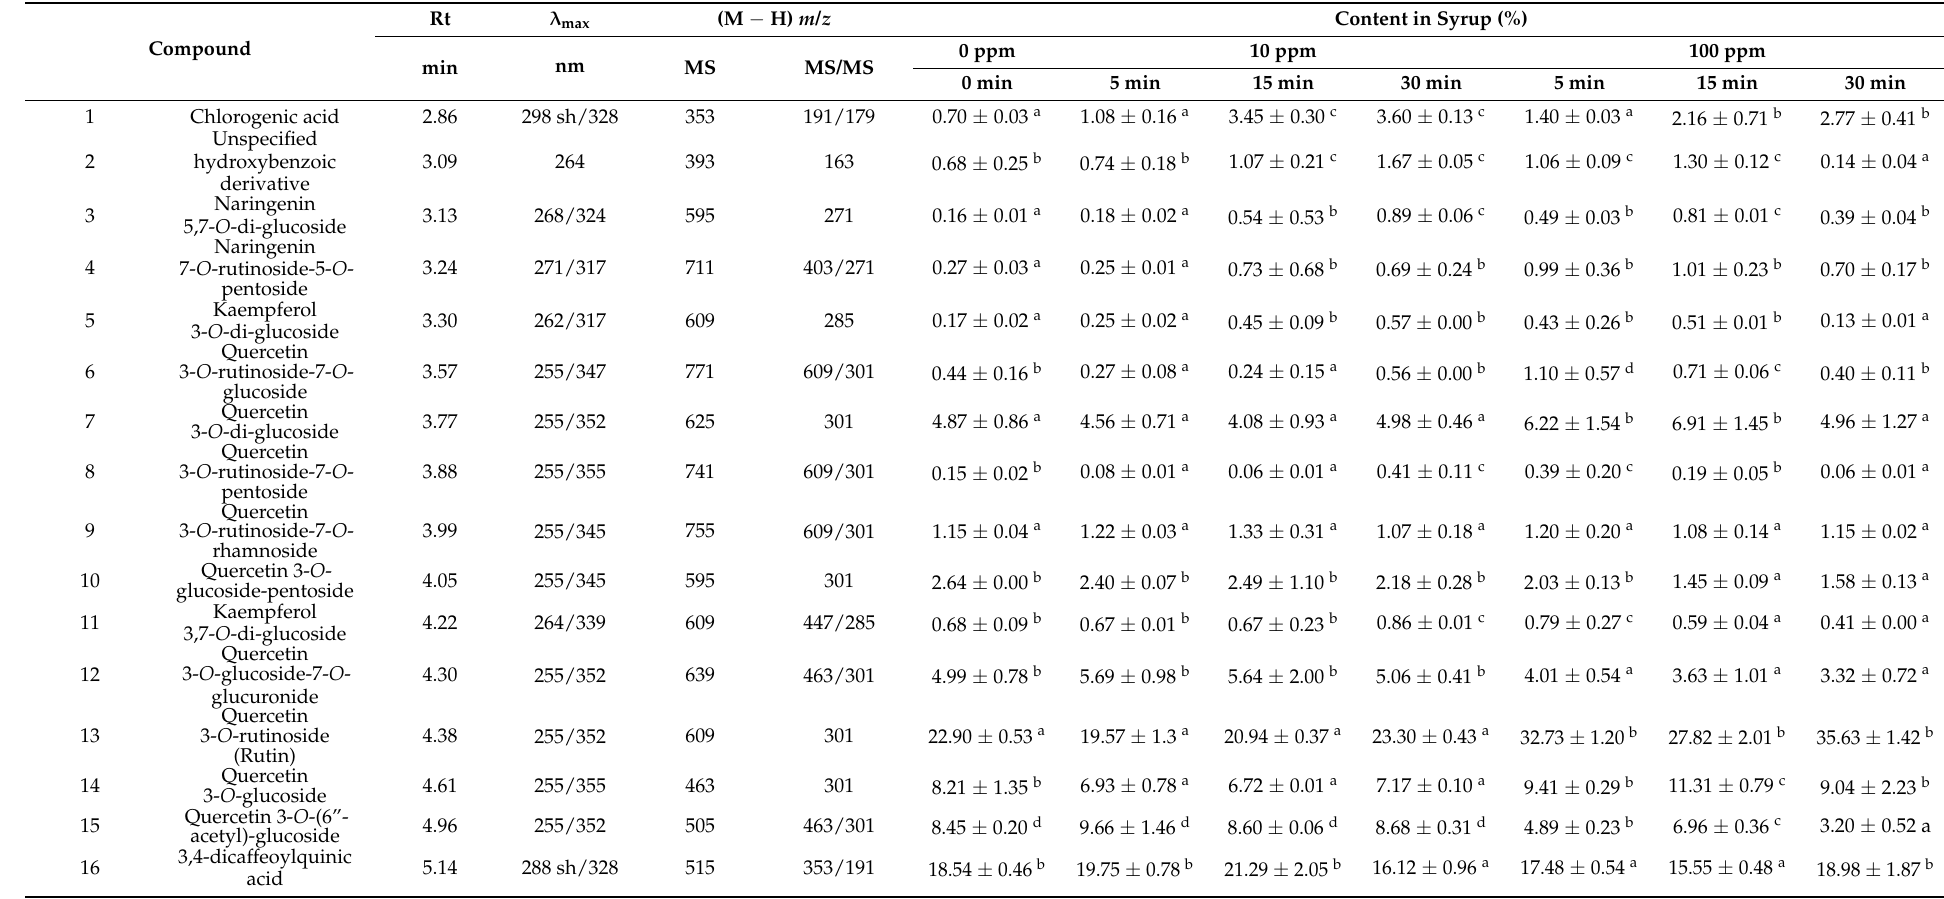
Table 1. Content (%) of individual phenolic compounds identified by UPLC–PDA–MS/MS in a syrup prepared with sugar syrup at a temperature of 30 ◦